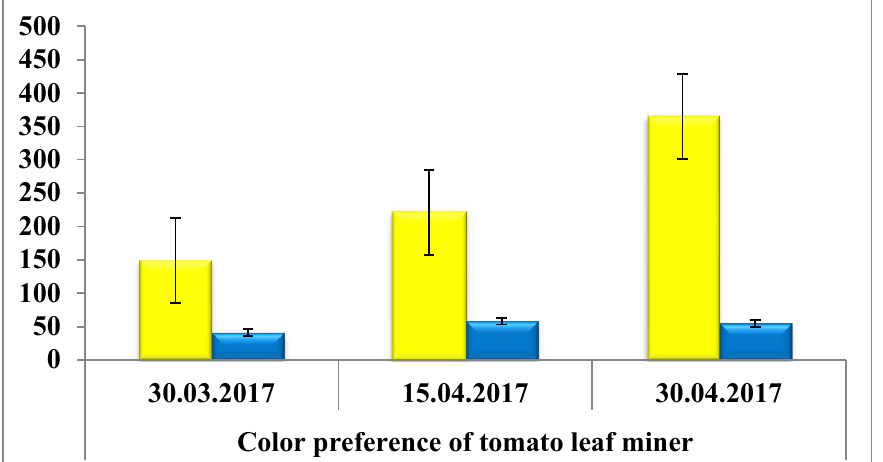
Horticulturae 2023 , 9 , x FOR PEER REVIEW Figure 1. Color preference of Liriomyza spp. 2017. Figure 1. Color preference of Liriomyza spp. 2017.